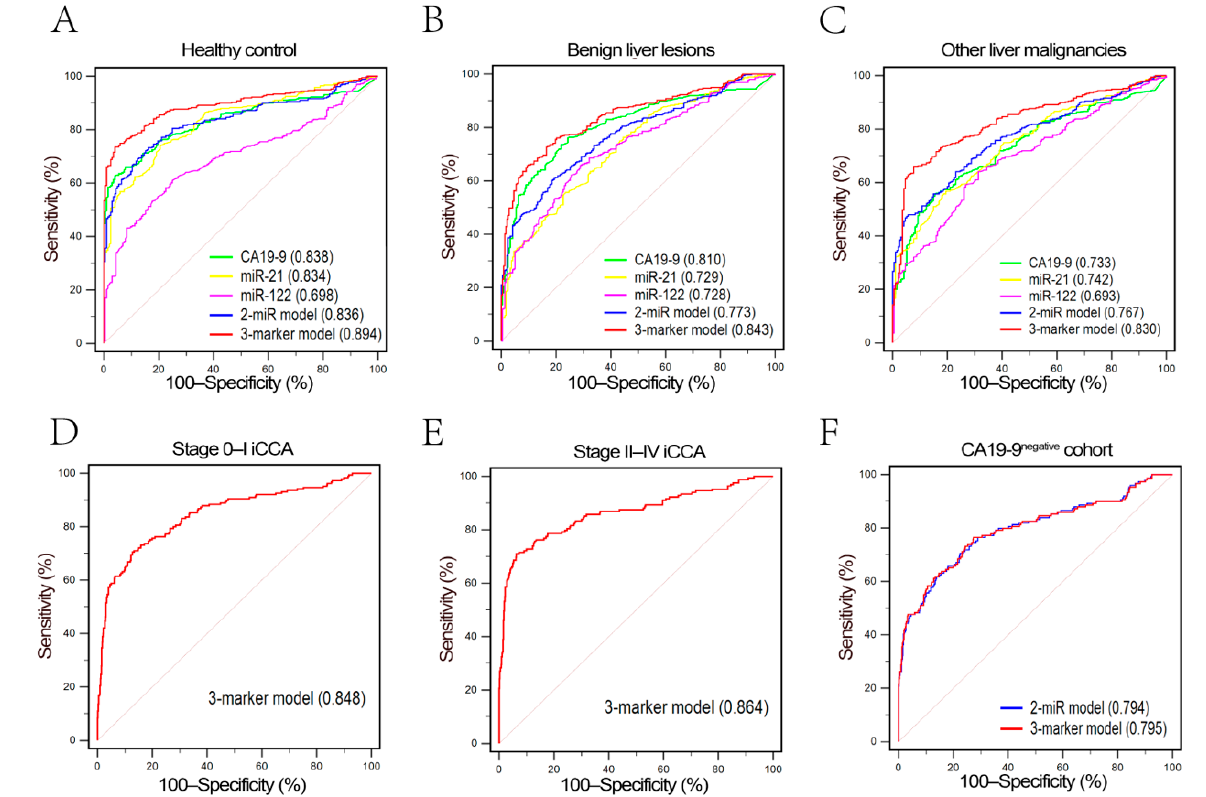
Figure 4. Subgroup ROC analysis for iCCA diagnosis. ( A – C ) Diagnostic performance of five parameters in healthy control subgroup, benign liver lesions subgroup and other liver malignancies subgroup. Three-marker model also demonstrated a preferable diagnostic efficacy than other parameters in three subgroups (Tables S3–S5). ( D , E ) Diagnostic efficacy of three-marker model for iCCA with different AJCC stage. Three-marker model still possessed a good diagnostic efficacy even in early stage iCCA. ( F ) Diagnostic efficacy of two-miR model and three-marker model for iCCA in CA19-9 negative cohort.